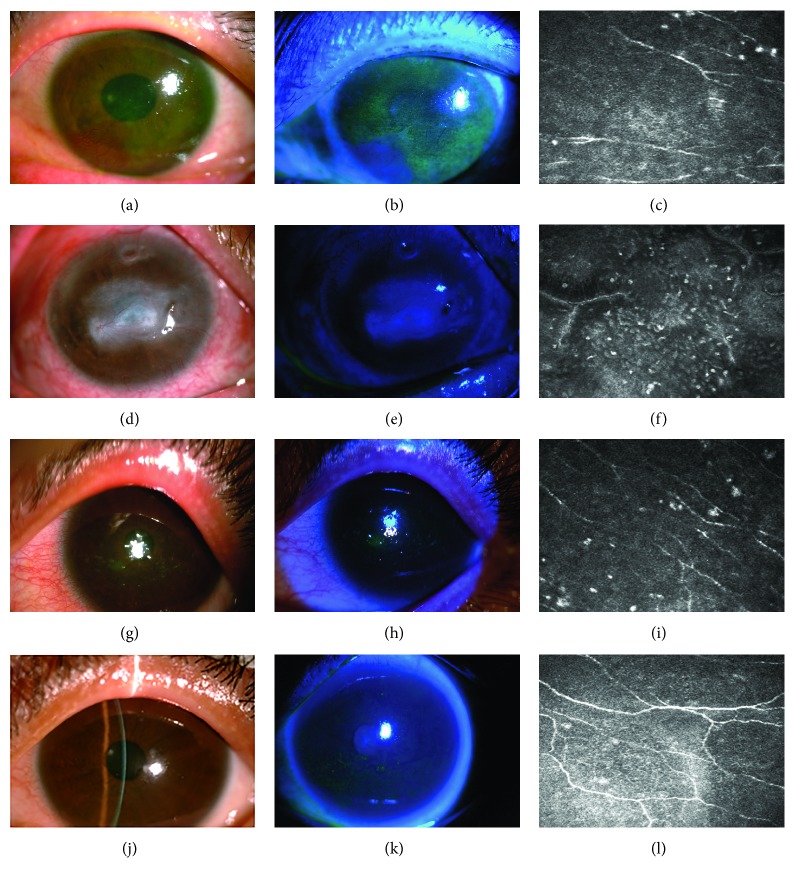
Ocular surface photograph, fluorescein staining, and confocal microscopy scan. (a1), (a2), and (a3) are the case of SS. (b1), (b2), and (b3) are the case of RA. (c1), (c2), and (c3) are the case of SLE. (d1), (d2), and (d3) are the case of SDE.